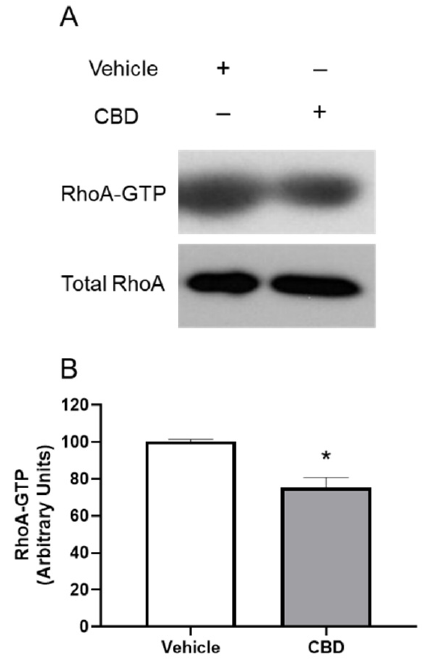
Figure 5. The effect of cannabidiol on RhoA activation. ( A ): representative Western blot of RhoA- GTP and Total RhoA for three experiments is shown. TM cells were serum starved overnight and treated with DMEM or DMEM containing 1 µ M CBD for 2 h, then RhoA activation was assessed. ( B ): densitometry quantification of RhoA activation for three experiments is shown. RhoA-GTP significantly decreased following treatment with CBD compared to the vehicle in TM cells. Results are expressed as mean ± SEM ( n = 3). Vehicle treated TM cell RhoA levels are normalized to 100%. * Significant difference from vehicle determined by t -test, p < 0.05.